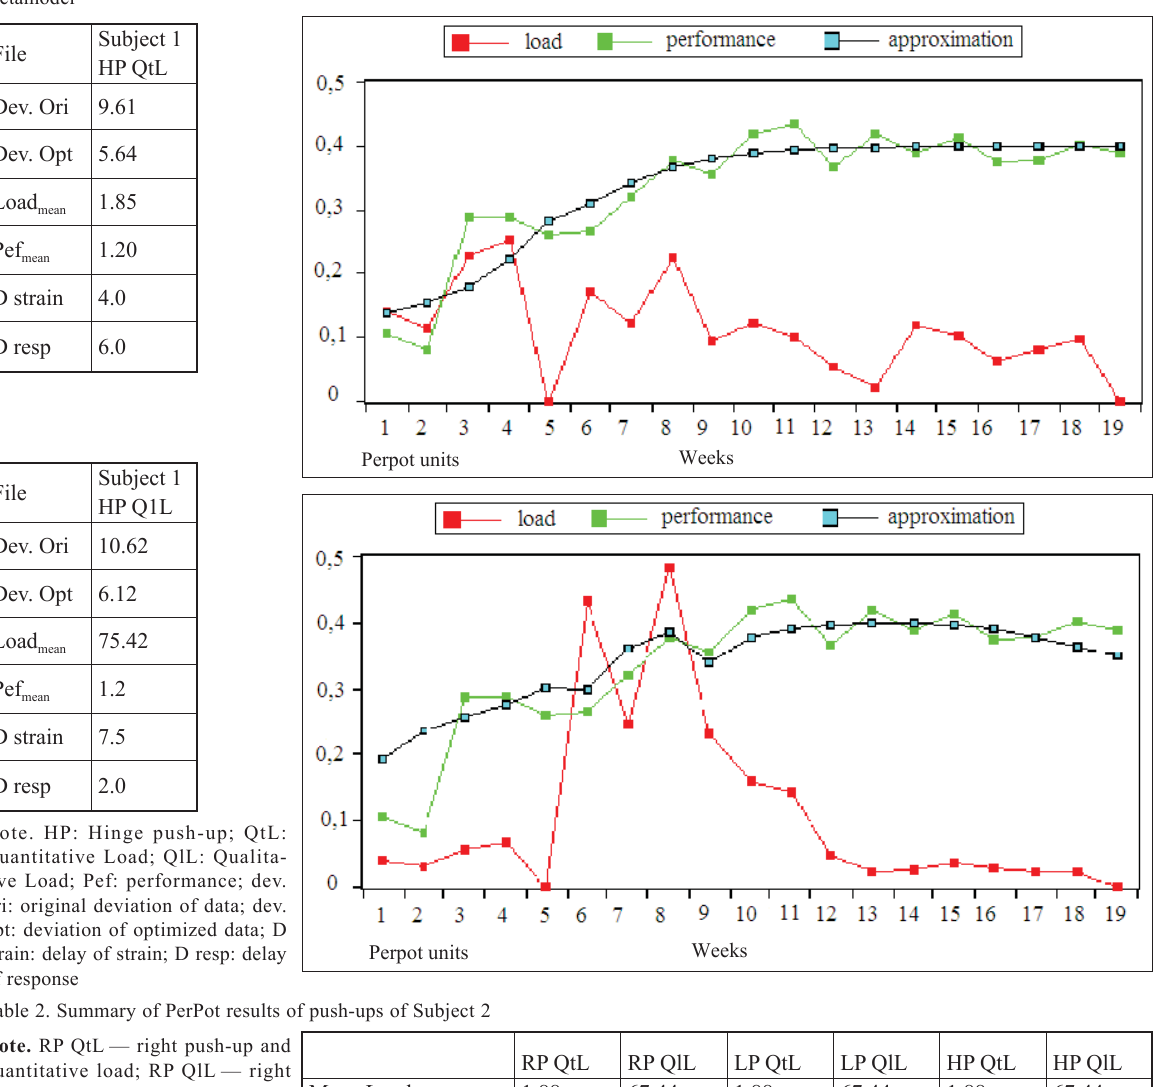
Table 2. Summary of PerPot results of push-ups of Subject 2 Note. RP QtL — right push-up and quantitative load; RP QlL — right push-up and qualitative load; LP QtL — Left push-up and quantitative load; LP QlL — Left push-up and qua- litative load; HP QtL — hinge push-up and quantitative load; HP QlL — Hin- ge push-up and qualitative